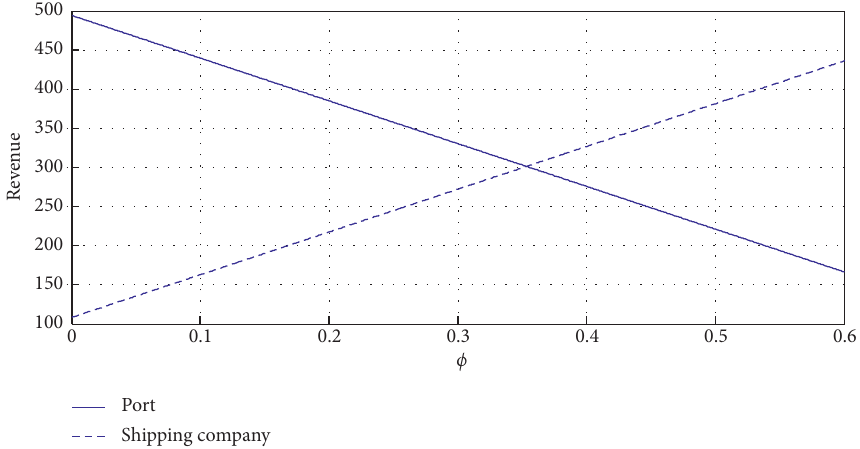
Figure 4: Profit and profit sharing coefficient of port and shipping enterprises.